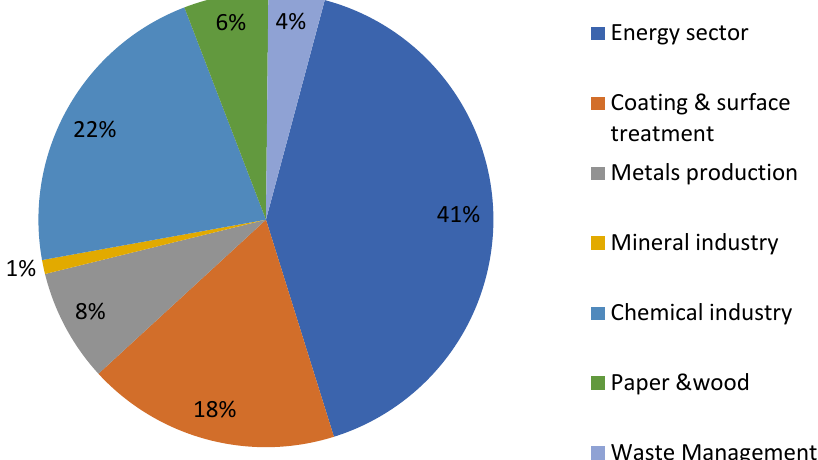
Figure 4. Sectors involved in High VOCs Emissions for the EU-27.